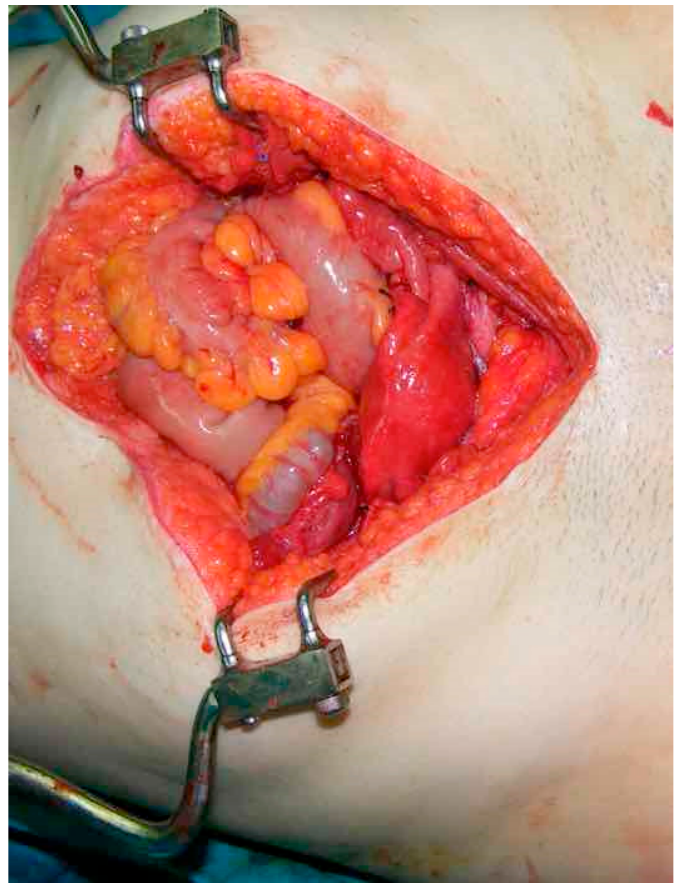
Figure 1. Situs after transplantation of the uterine